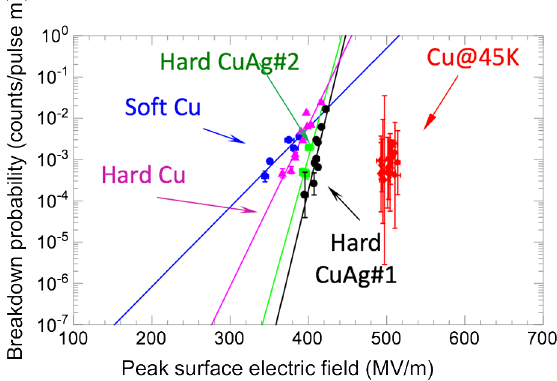
FIG. 2. Breakdown probability in per pulse meter of structure length as a function of peak surface electric field in single cell X-band accelerating structure tests. The introduction of a harder alloy (CuAg, two different samples, indicated as #1 and #2) improves the breakdown as predicted; the effect of operation at 45 deg K is more dramatic, permitting surface electric fields to a threshold at 500 MV = m (from Ref.